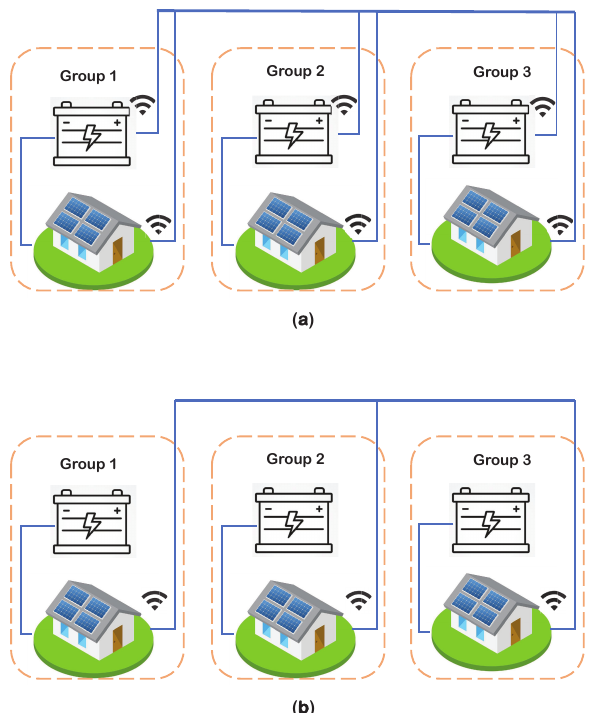
Figure 2. Proposed case configuration for case studies: ( a ) Case 1, SBEMS; ( b ) Case 2,